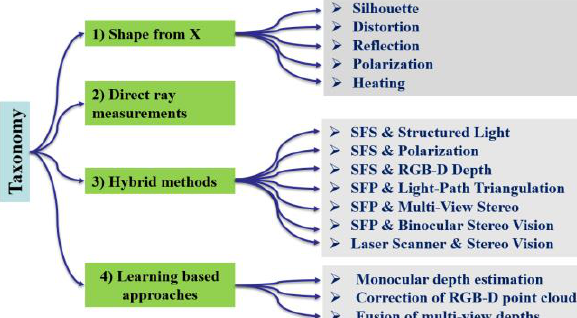
Figure 2. General taxonomy of 3D digitization of transparent and glass surfaces. SFS and SFP are the abbreviation for Shape from Silhouette and Shape from Polarization,